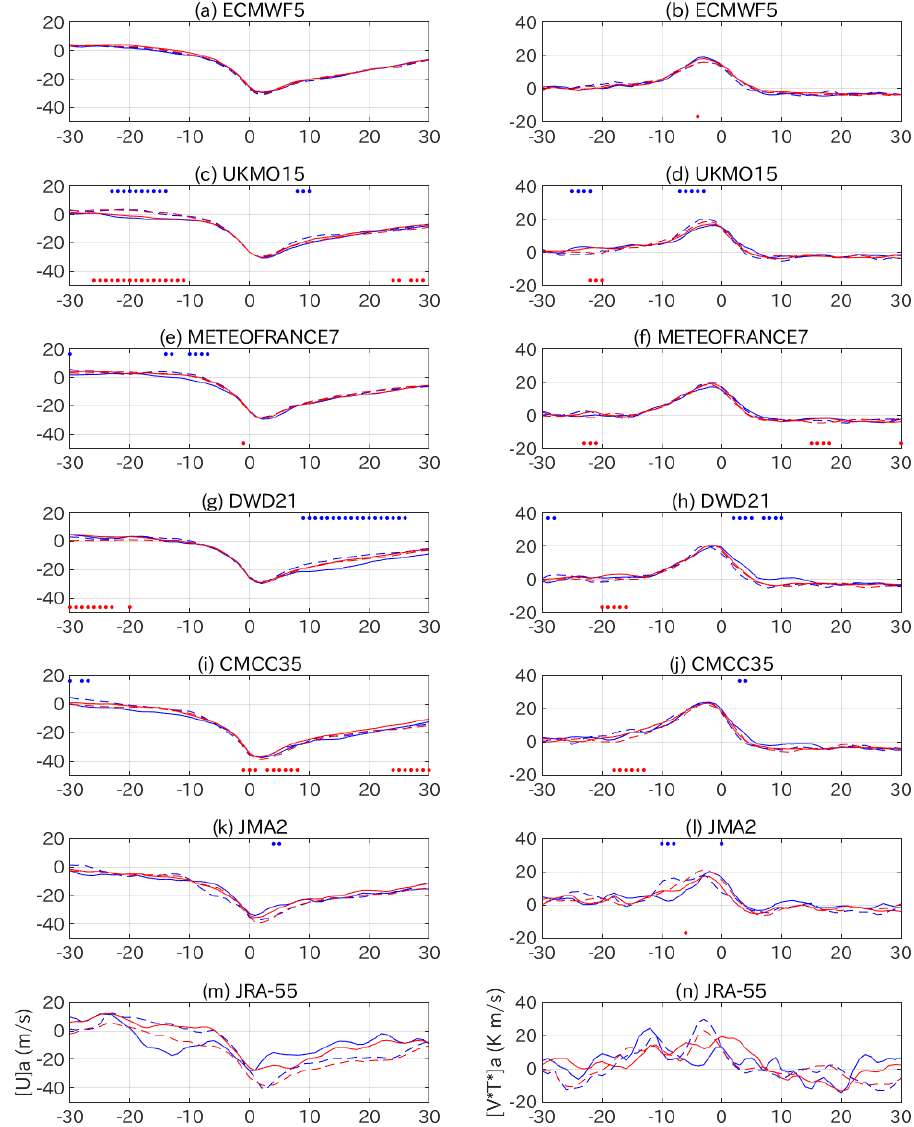
Figure 8. (Left panels) Similar to Figure 2d, but using MSSWs separately for LA, EL, ELY, and WLY for each system and JRA-55 data. Blue lines are for LA (broken) and EL (solid), and red lines are for ELY (broken) and WLY (solid). Dots denote significant differences at the 95% level (two side test) between LA and EL (blue dots), or between ELY and WLY (red dots). Right panels are similar, but plot waves 1–3 heat flux anomalies as in Figure 2e.